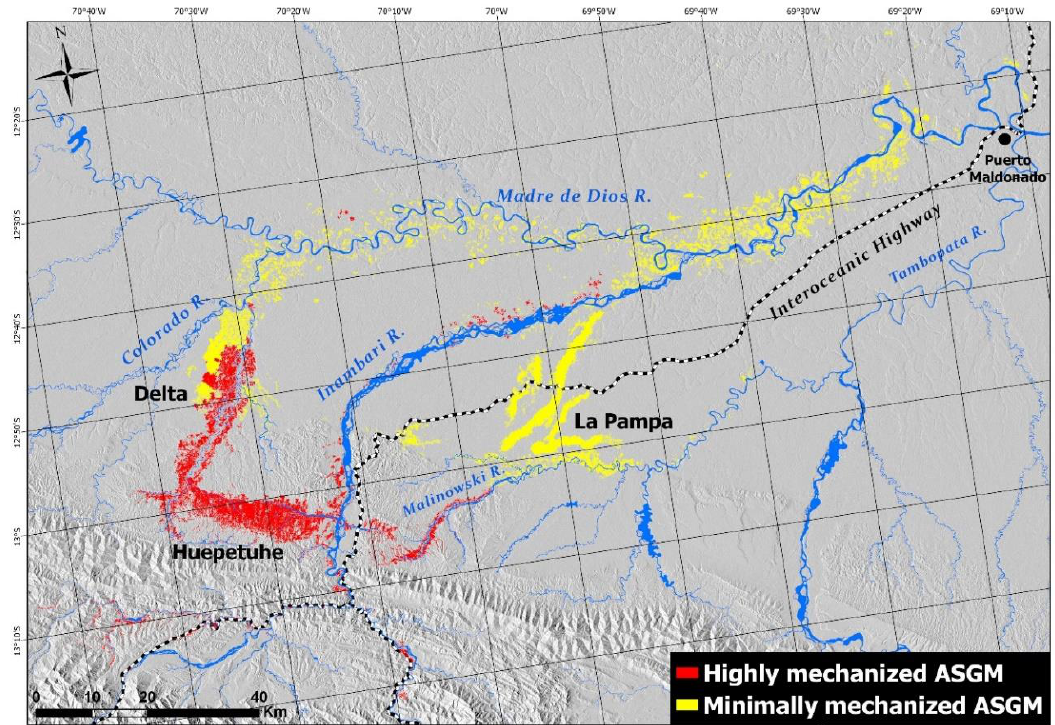
Figure 4. Distribution of deforestation caused by different types of gold mining operations in the Southeastern Peruvian Amazon. Highly mechanized mining (red) uses excavators, front loaders, and trucks to move sediments for processing. Minimally mechanized (yellow) uses water cannons and suction pumps; see Figure 3 for visual depictions of types.